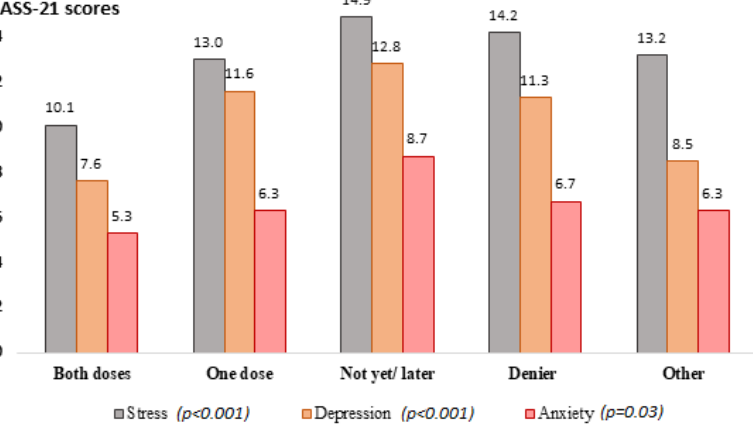
Figure 1. DASS-21 scores for the Depression, Anxiety, and Stress constructs by participants’ vaccination status. Colors should be used for this figure in print. The multivariate adjusted regression analyses revealed that, compared to those fully vaccinated, deniers of vaccination had significantly higher scores (6.37 (95% confidence interval = 3.69–9.04, p ‐ value < 0.001), 2.55 (95% confidence interval = 0.26–4.84, p ‐ value = 0.029), and 5.84 (95% confidence interval = 2.90–8.77, p ‐ value <0.001)) across the Stress, Anxiety, and Depression subscales respectively. Similar associations were also observed across all three mental health subscales for those who were not yet vaccinated but were planning to be vaccinated later compared to vaccinated individuals. We also observed an increased score by 2.6 points on the Depression subscale for individuals who had received only one dose of the vaccines, compared to those who were vaccinated with both doses (adjusted coefficient = 2.63, 95% confidence interval = 1.53–3.73, p ‐ value < 0.001). The find ‐ ings were similar in supplemental sensitivity analyses handling missing data.